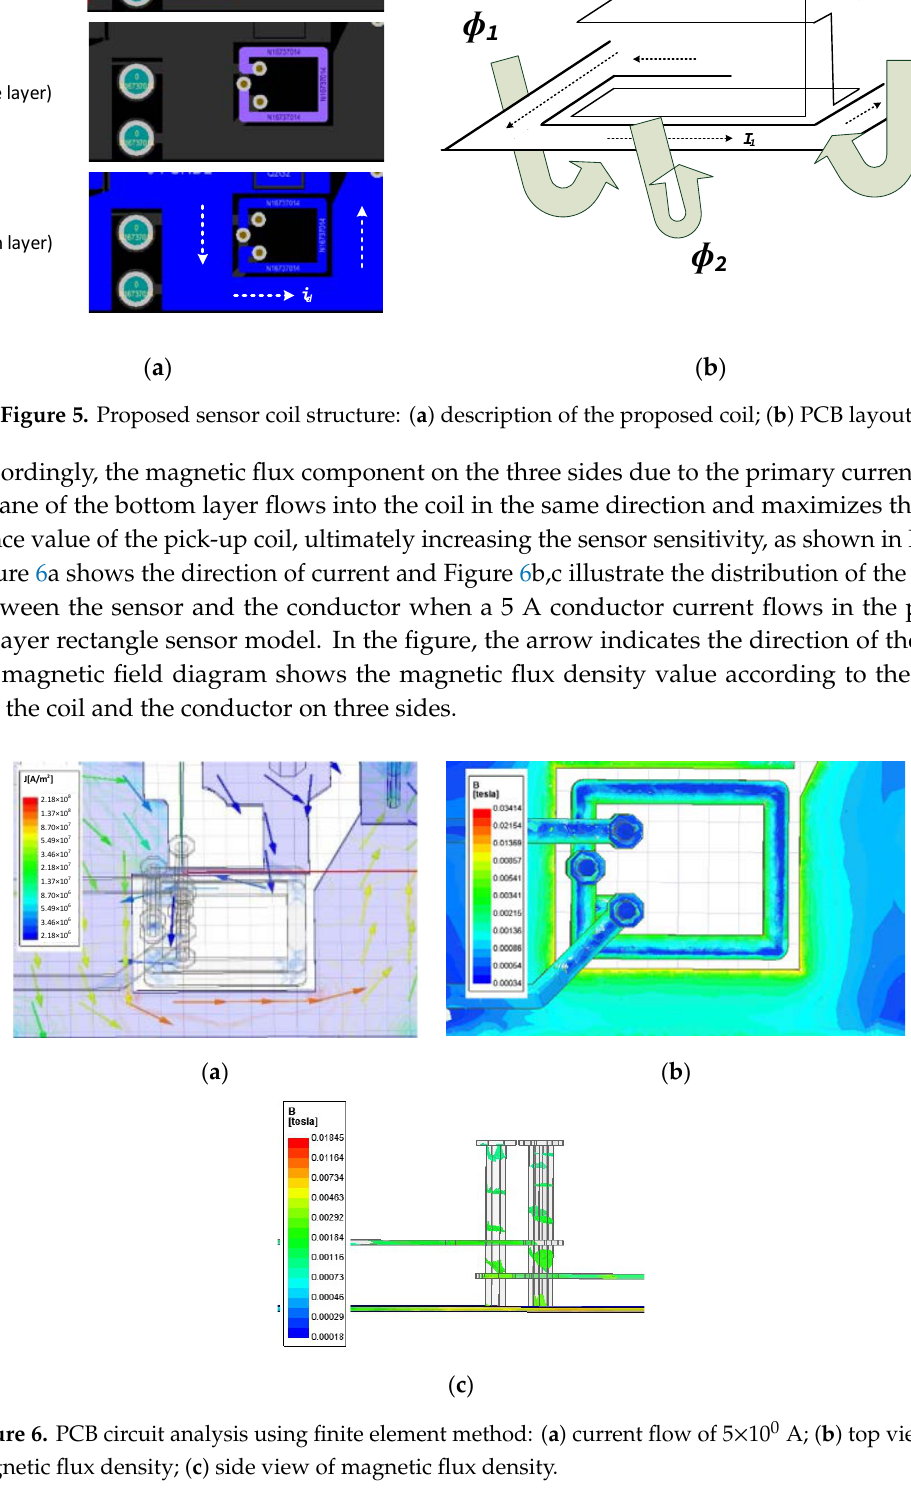
( b ) Figure 7. Proposed pick-up coil model: ( a ) equivalent ℼ model; ( b ) geometry of a single coil. s B ds φ=